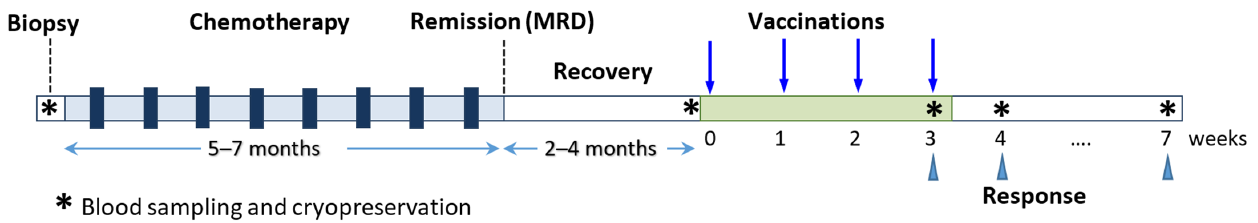
Figure 2. Overall treatment scheme. MRD—minimal residual disease.